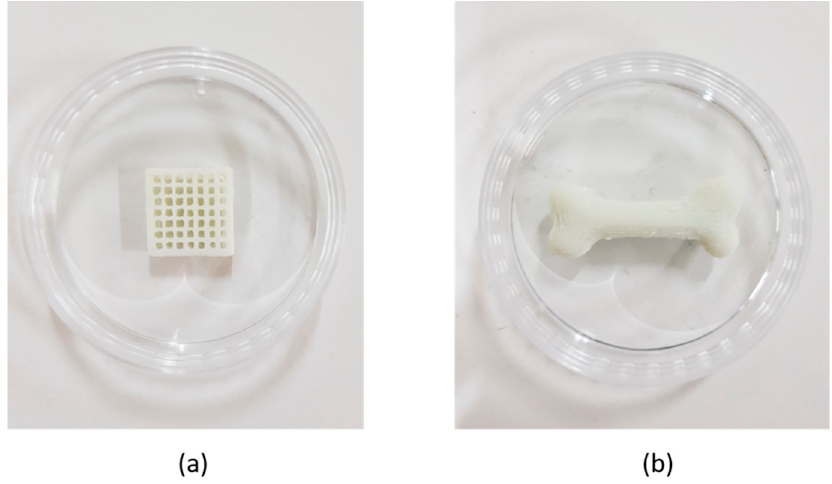
Figure 7. ( a ) 3D-printed bone scaffold and ( b ) bone mimetic structure.